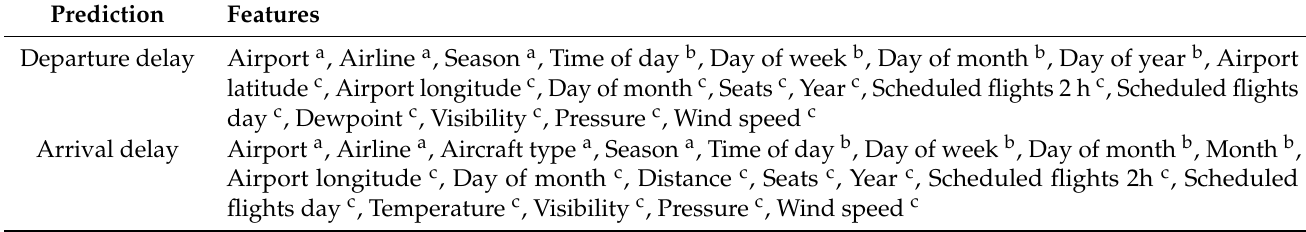
Table 1. Feature encoding and selection for flight delay prediction.